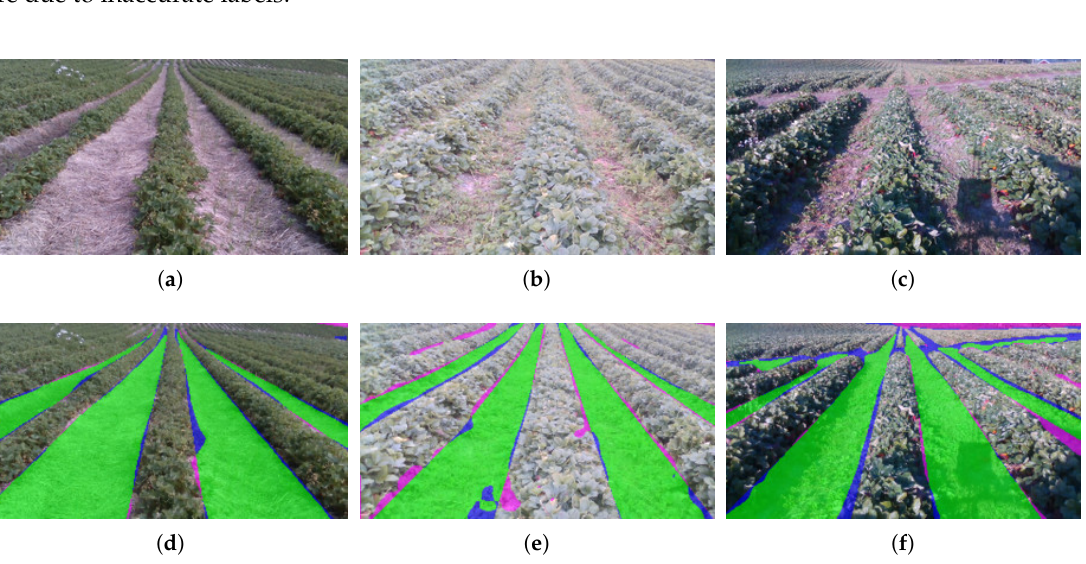
Figure 11. Presents the example input images during different stages of the harvesting season ( a – c ) and their CNN segmentation results for the lane class ( d – f ). Green is correct prediction, blue is undetected soil, magenta is undetected vegetation. Best viewed in